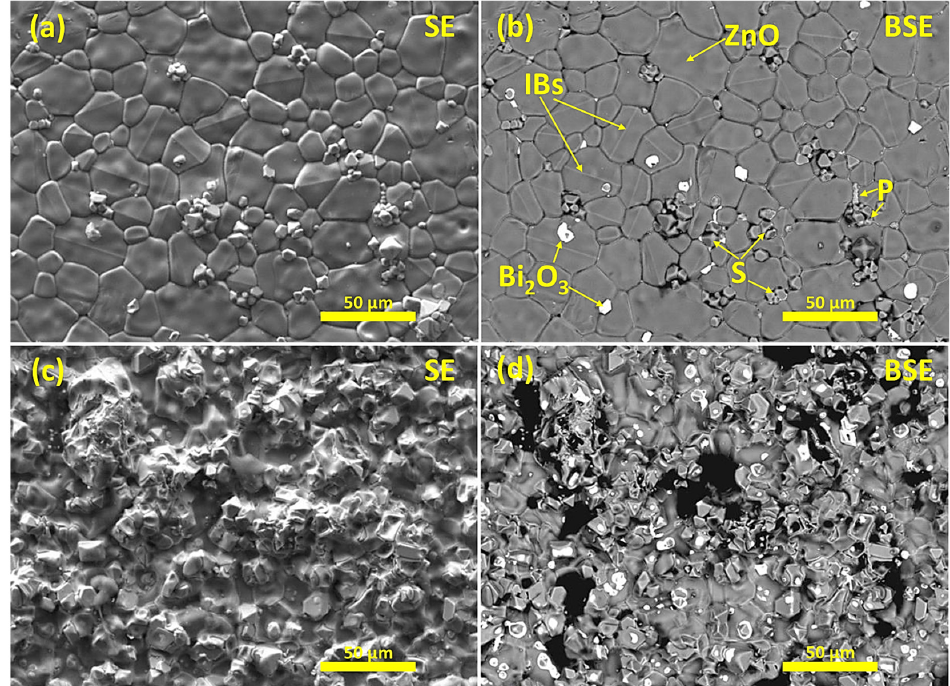
Figure 6. SEM images of ZnO varistors after sintering with ( a , b ) having backing ceramic (refractory Al 2 O 3 crucible) to cover the bottom surfaces, whereas ( c , d ) shows sintering of ZnO varistor green compact freely in air, i.e., top side. Here ( a , c ) represent secondary electron (SE) imaging for topographical features, while ( b , d ) represent phase contrast and microstructural composition in backscattered electron (BSE) imaging mode.